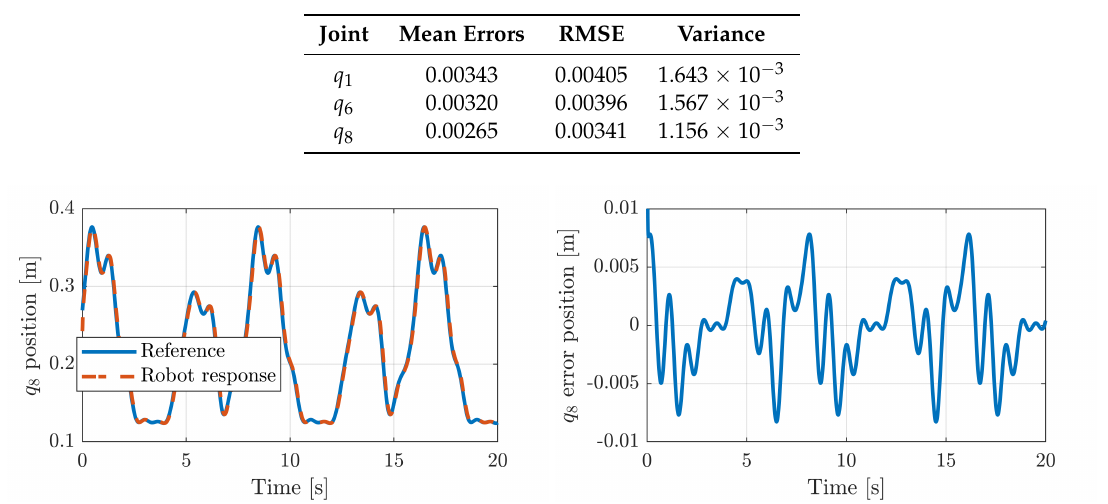
Table 2. Robot position errors (mean and RMSE) and variance.